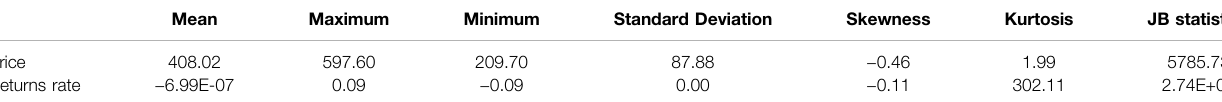
TABLE 1 | Descriptive statistics of data.